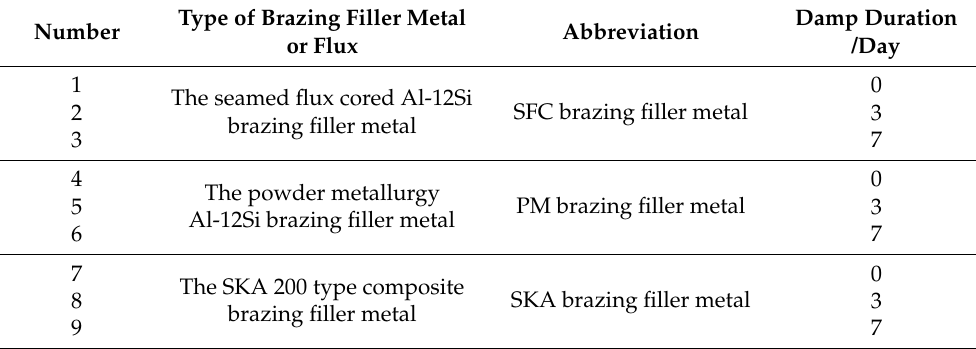
Table 1. Abbreviation of brazing filler metal samples under different moisture